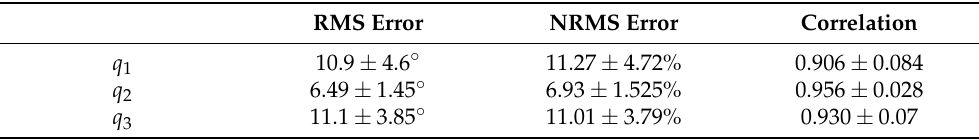
Table 1. UKF validation with respect to the Xsens system for shoulder joints estimation. In each column, RMS, Normalized RMS and correlation coefficient are reported in terms of the median and half of the interquartile